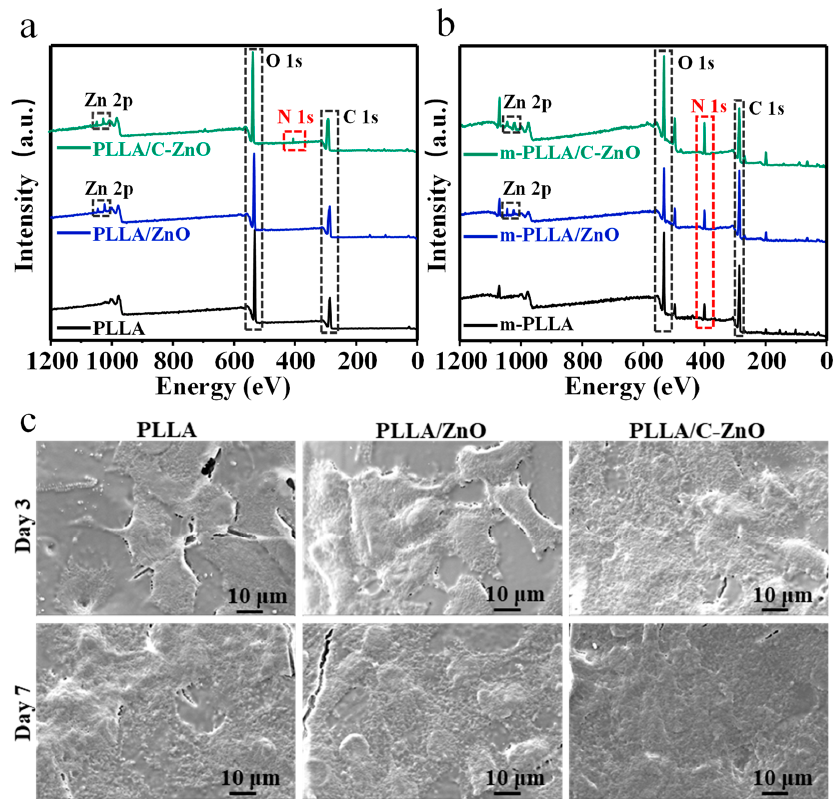
Figure 4. XPS spectra for ( a ) the initial scaffolds and ( b ) the scaffolds after being immersed in the cell media. ( c ) Cell adhesion morphologies on the scaffolds. The cell adhesion morphologies are shown in Figure 4c. After culturing for 3 days, it could be seen that the cells were firmly adhered to the scaffold and displayed flat and stretched shapes. After culturing for 7 days, the number of cells on both scaffolds increased. In addition, the number and thickness of cells on the PLLA/C ‒ ZnO scaffold rose dramatically, indicating that the PLLA/C ‒ ZnO scaffold offers excellent cytocompatibility. The cell toxicity of the scaffolds was assessed using fluorescence assays. The results are shown in Figure 5a. On day 3, the PLLA and PLLA/ZnO scaffolds exhibited only a small number of cells. Comparatively, the PLLA/C ‒ ZnO scaffold groups displayed a comparatively high number of living cells with the PLLA scaffold. As the culture period progressed, the number of cells in all scaffolds increased. Among them, the PLLA/C ‒ ZnO scaffold displayed the largest number of living cells over time, suggesting that the PLLA/C ‒ ZnO scaffold offered superior biocompatibility.